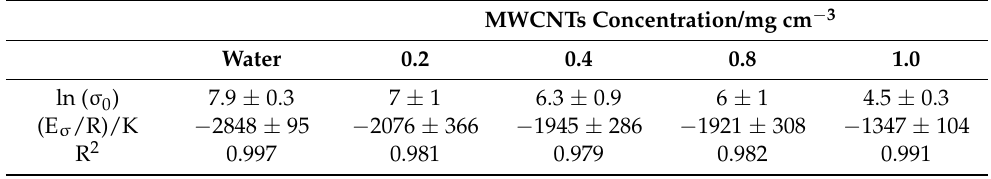
Table 10. Conductivity–temperature model parameters for MWCNTs dispersed in water.